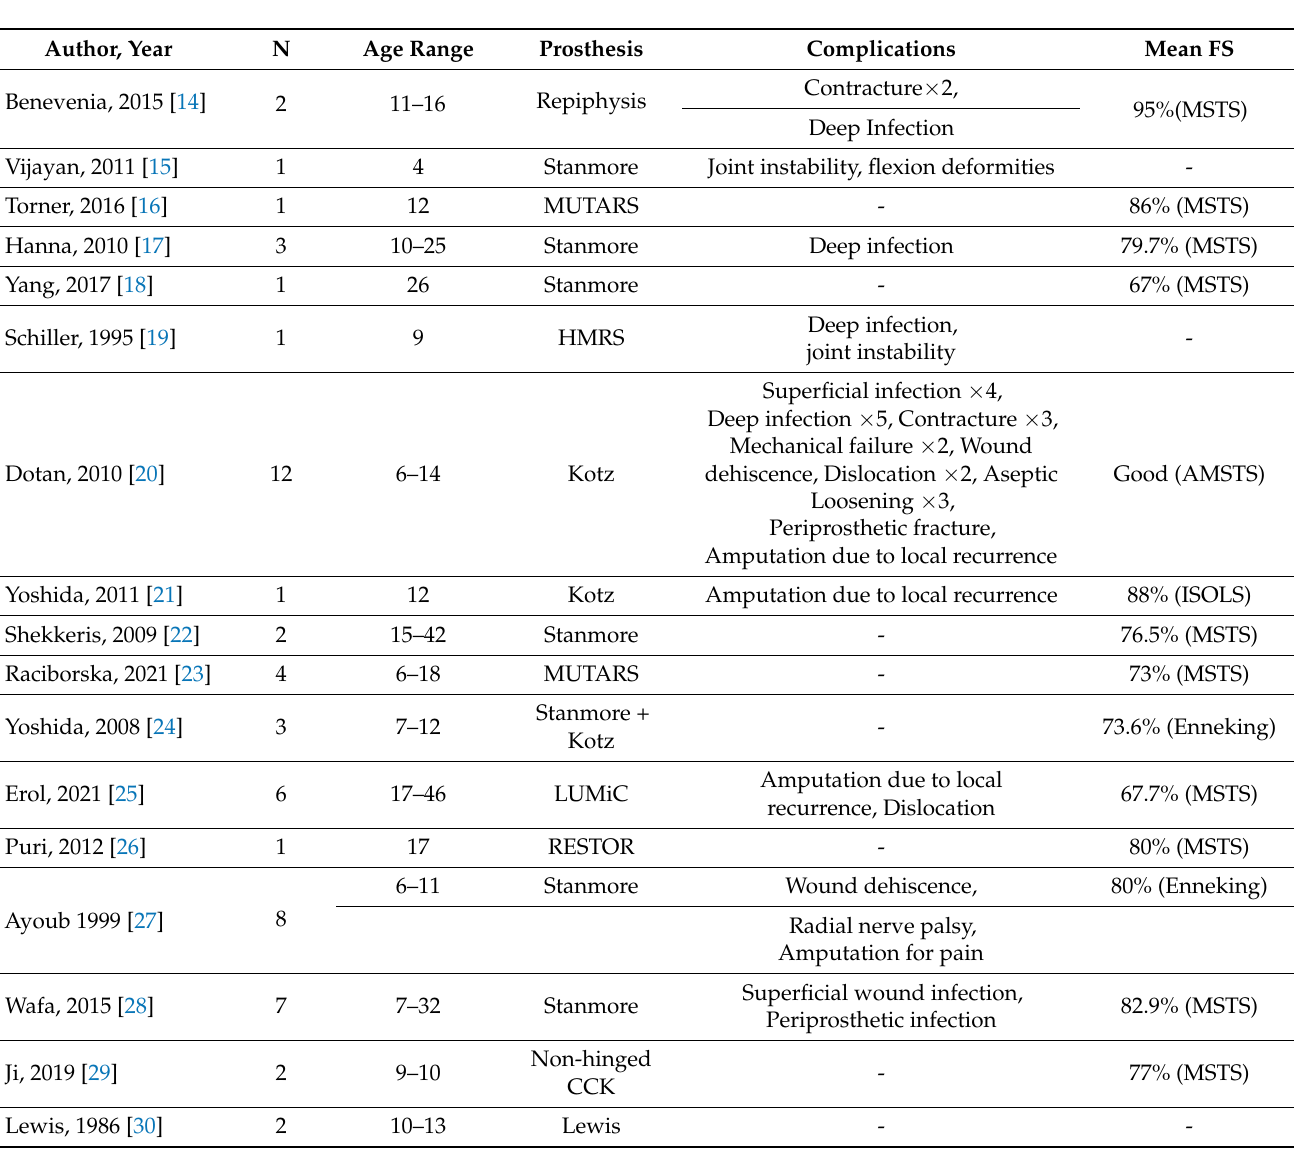
Table 2. Summary of extracted date of patient characteristics prosthesis type and complications from included